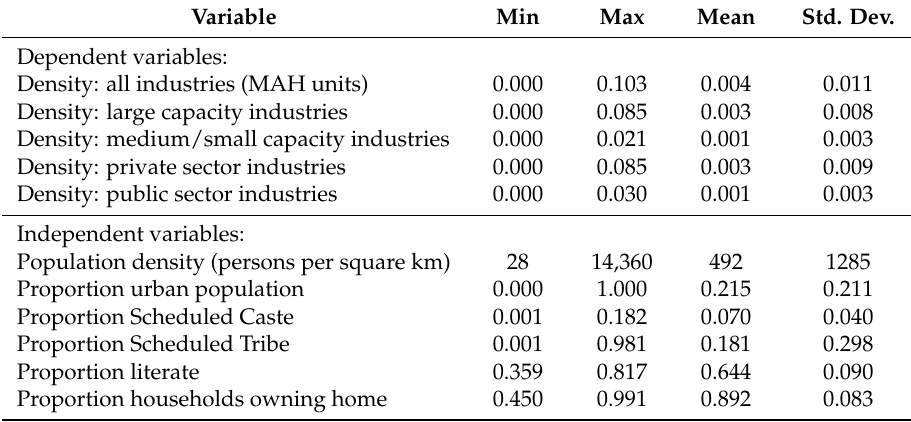
Table 1. Summary statistics for variables analyzed ( n = 225